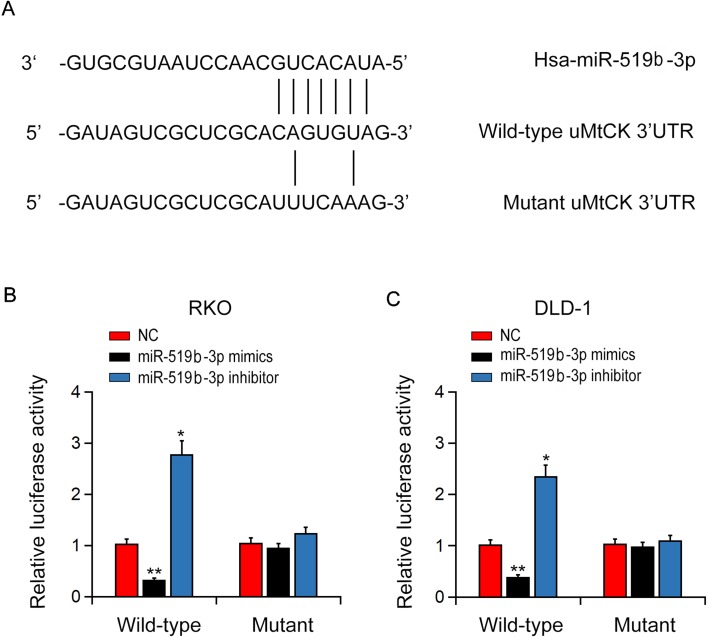
miR-519b-3p could directly target the 3′-UTR of uMtCK. (A) The putative miR-519b-3p binding site in the 3′-UTR of uMtCK mRNA. The dual-luciferase reporter assay was used in RKO (B) and DLD-1 (C) cells transfected with miR-519b-3p mimics or inhibitor. *p < 0.05, **p < 0.01 vs. NC. NC, negative control.